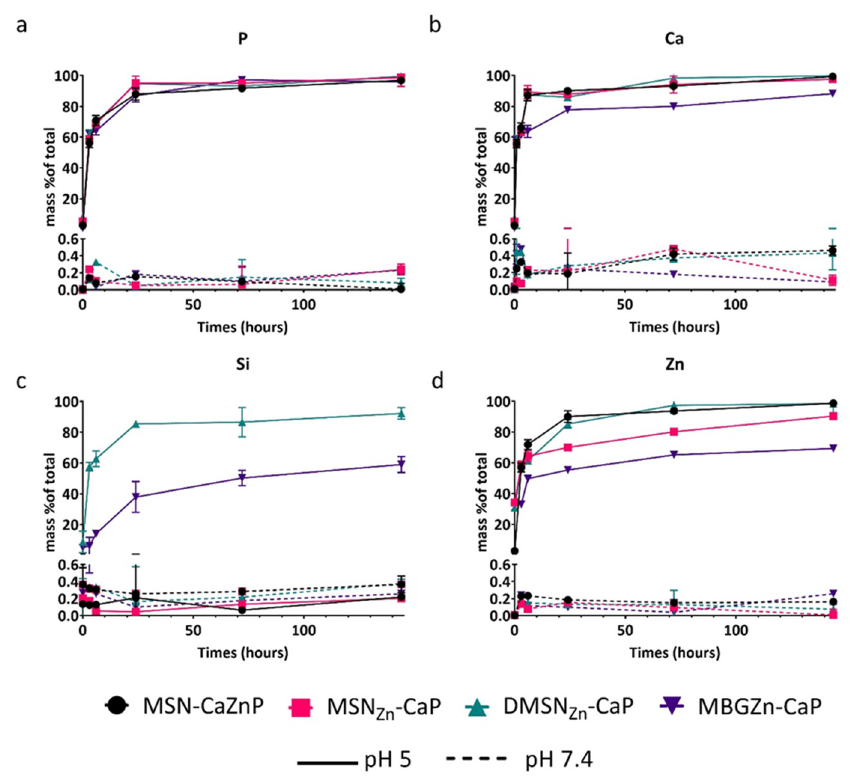
Figure 2. Ion release profiles from MSN-CaZnP (black), MSN Zn -CaP (red), DMSN Zn -CaP (green) and MBGZn-CaP nanoparticles analysed by ICP-MS; ( a ) P, ( b ) Ca, ( c ) Si and ( d ) Zn ions release in cacodylate buffer pH 5 (line) and pH 7.4 (dashed line).